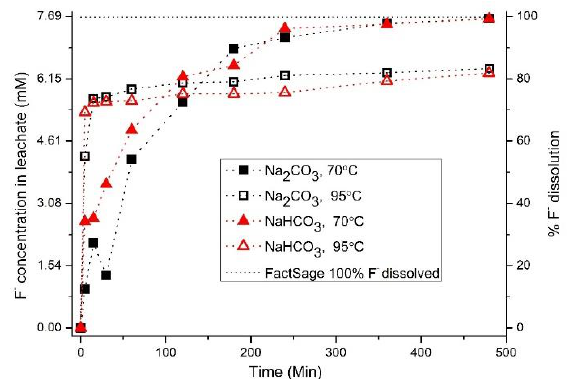
Figure 1. Experimental data for dissolution of CaF 2 , at pH 10.6 as function of time in comparison with thermodynamically calculated concentration based on the experimental conditions.